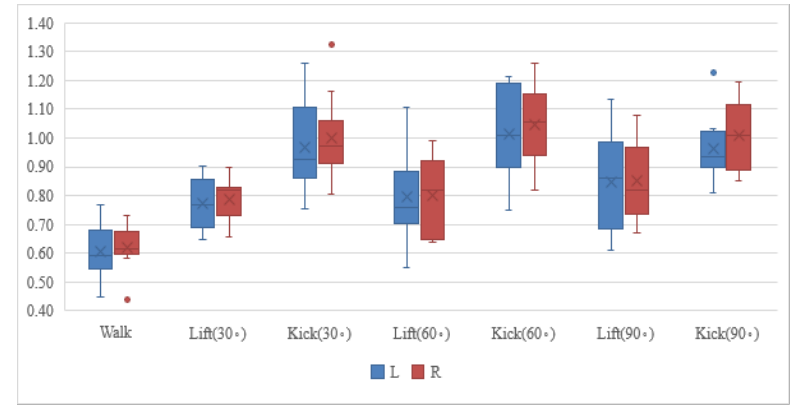
Figure 2. The box plot of pretest male and female left and right feet average in each mode of walking, lifting legs and kicking.